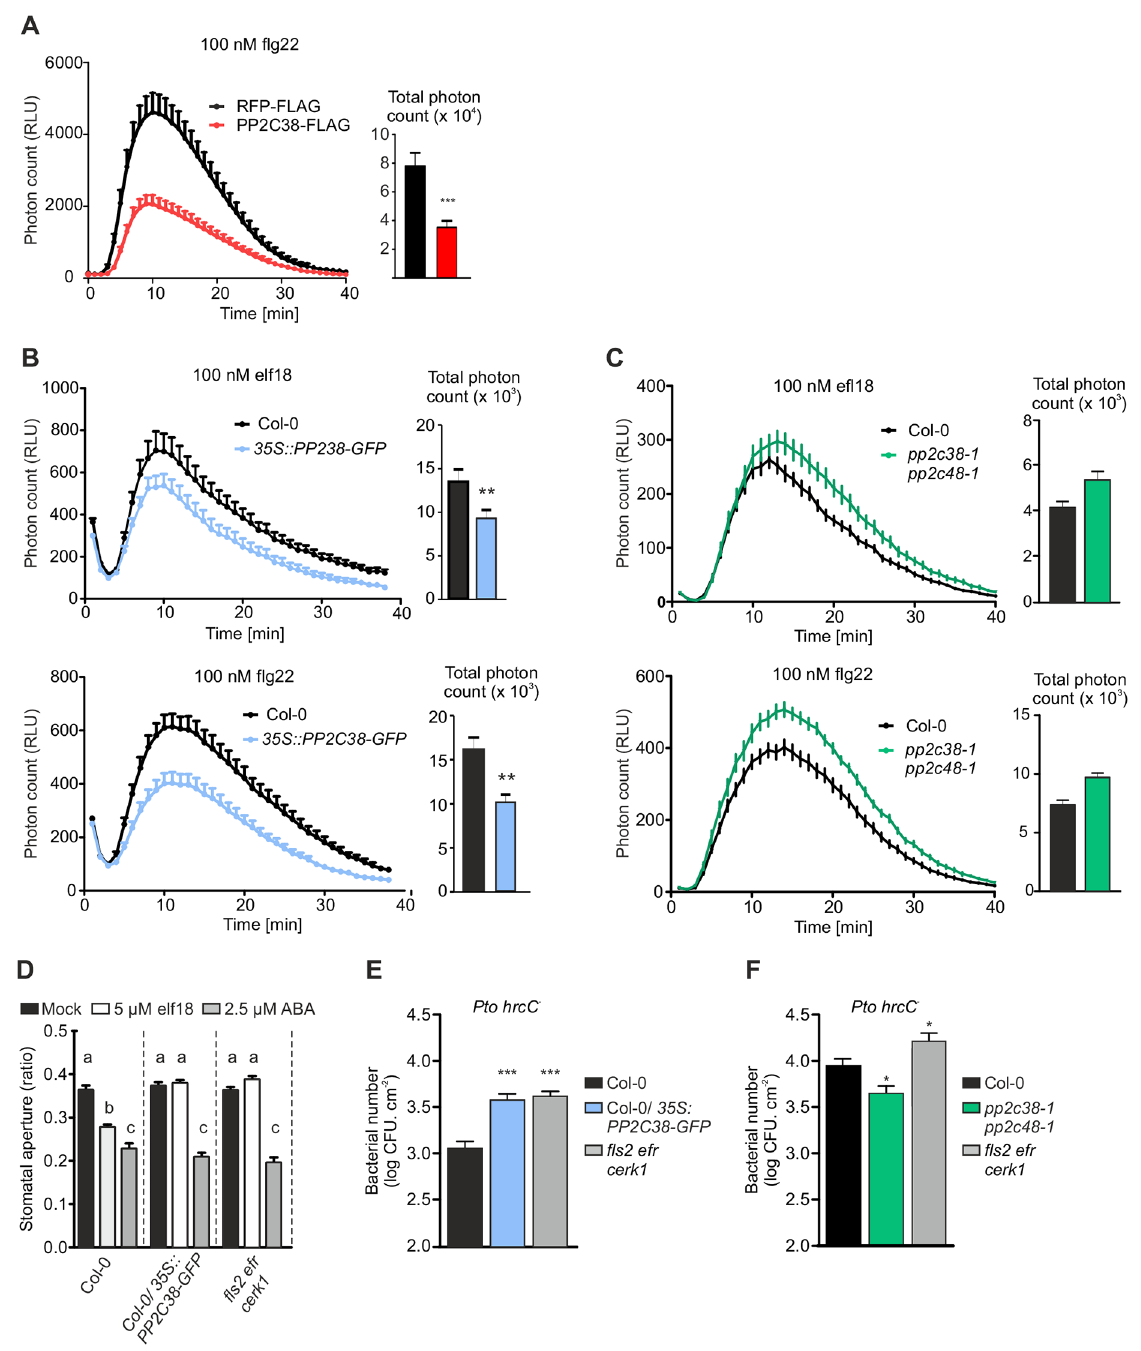
Fig 4. PP2C38 regulates PAMP-induced ROS burst and stomatal immunity. (A-B) Overexpression of PP2C38 impairs the ROS burst induced by 100 nM flg22 in N . benthamiana (A), and by 100 nM flg22 or elf18 in Arabidopsis (B). Values are mean ± SE (n = 12) and are expressed in relative light units (RLU). Significant differences are designated by asterisks ( *** p < 0.001; ** p < 0.01) based on unpaired Student ’ s t test. Experiment replicated three times with similar results. (C) Loss of PP2C38 and PP2C48 enhances ROS production induced by 100 nM elf18 or flg22. Values are mean ± SE (n (cid:3) 20) and are expressed in relative light units (RLU). Significant differences are designated by asterisks * p < 0.05) based on unpaired Student ’ s t test. Experiment replicated three times with similar results. (D) PP2C38 regulates elf18- but not ABA-induced stomatal closure. Stomatal aperture was measured 2 h after 5 μ M elf18 or 2.5 μ M ABA treatment. Values are mean ± SE (n > 50; one-way ANOVA, Tukey post hoc test). Different letters indicate significantly different values at p < 0.001. Experiment replicated three times with